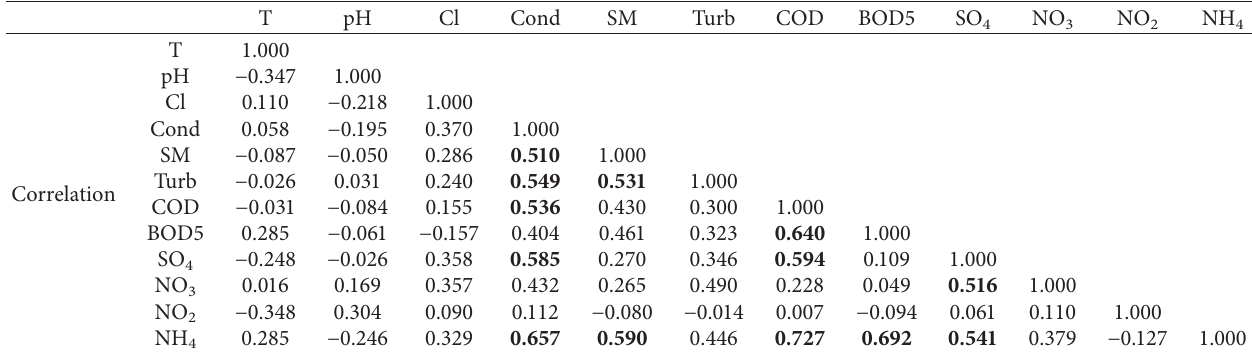
Table 4: Correlation matrix.